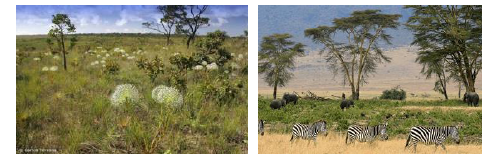
Figure 2. (left) Brazilian cerrado, (right) African savannah.